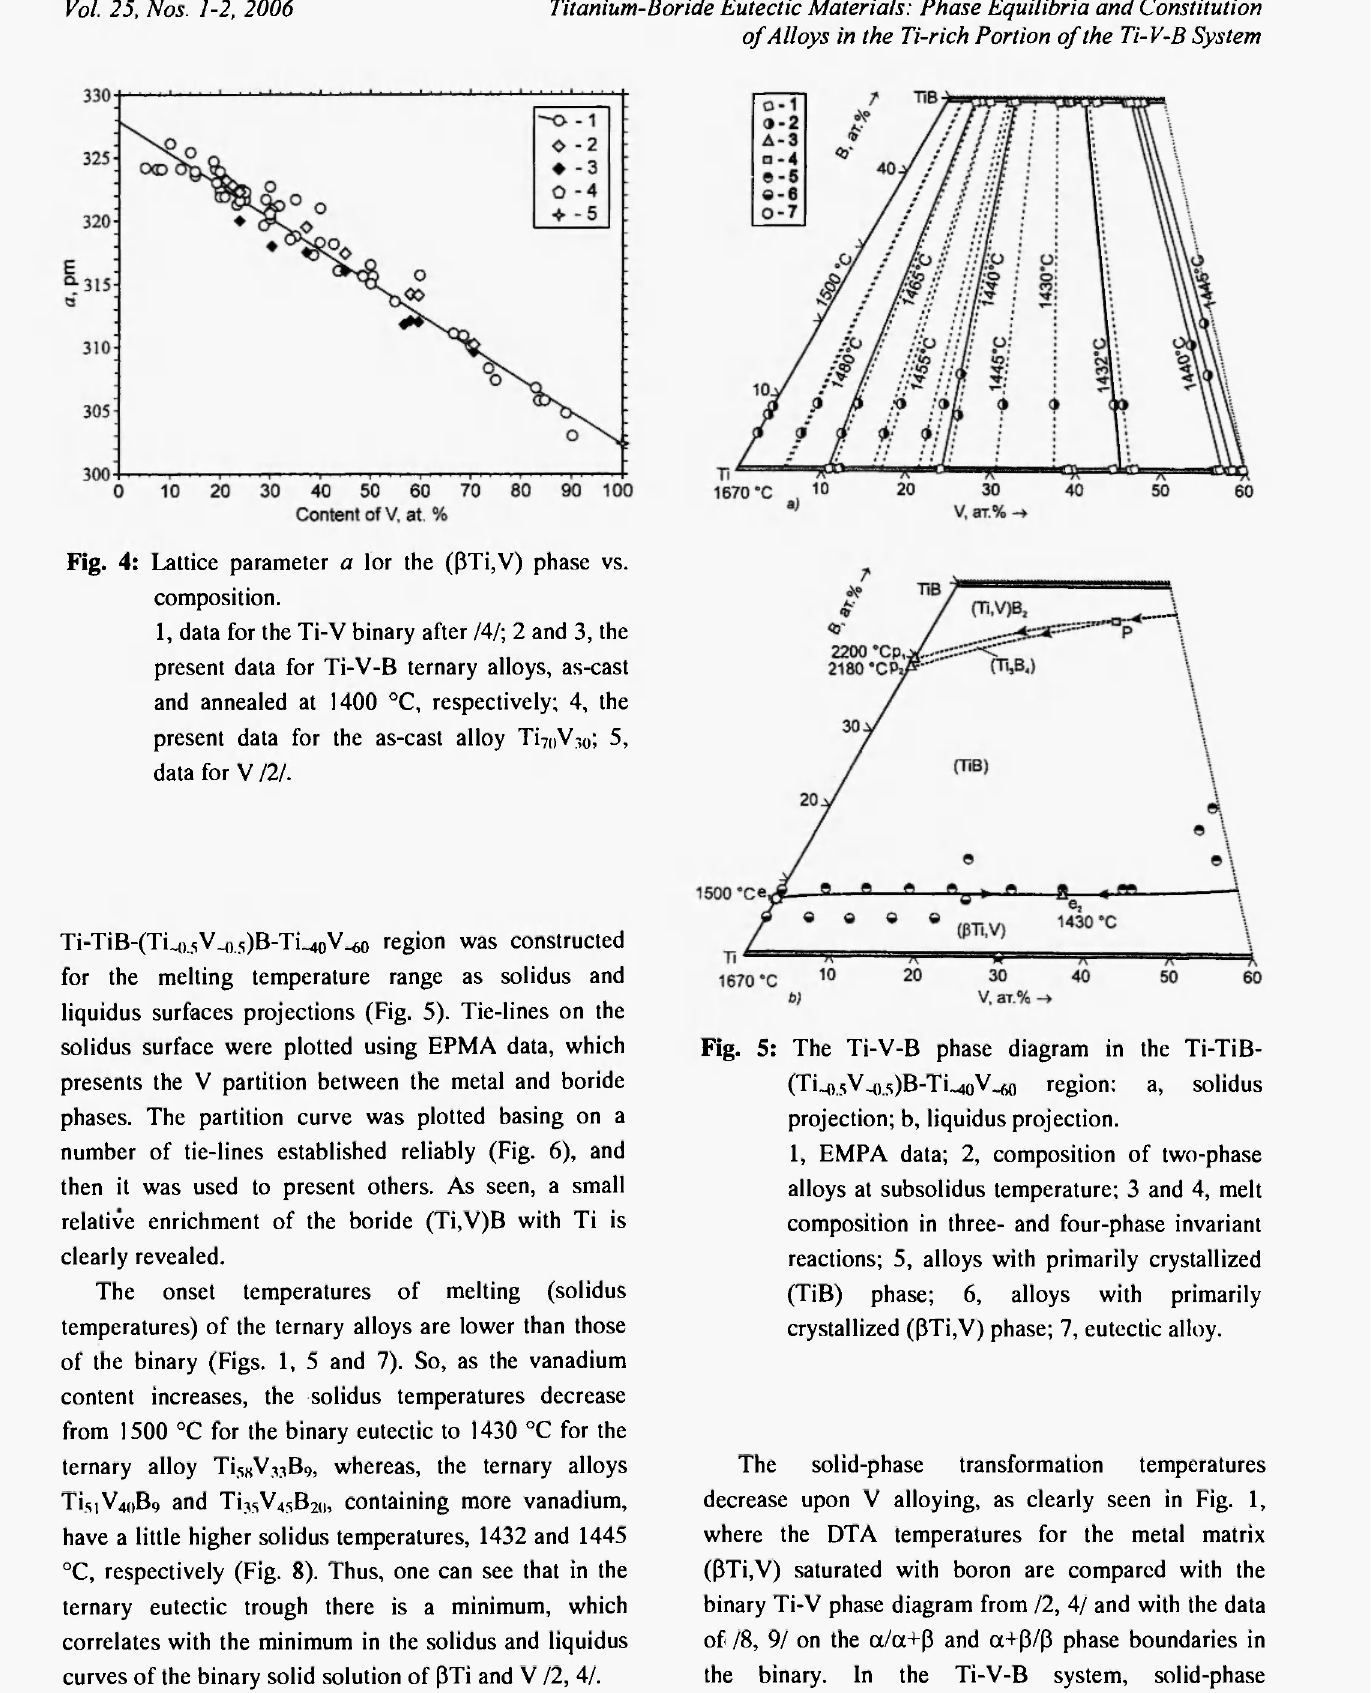
Fig. 4: Lattice parameter a lor the (ßTi,V) phase vs. composition.